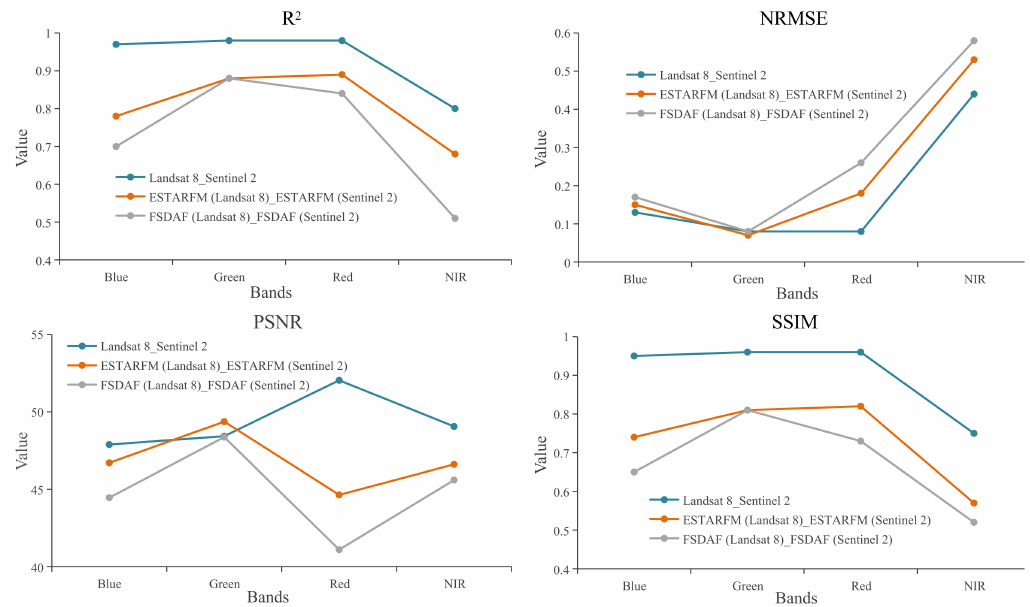
Figure 9. Consistency evaluation index of Landsat 8 and Sentinel 2 images.